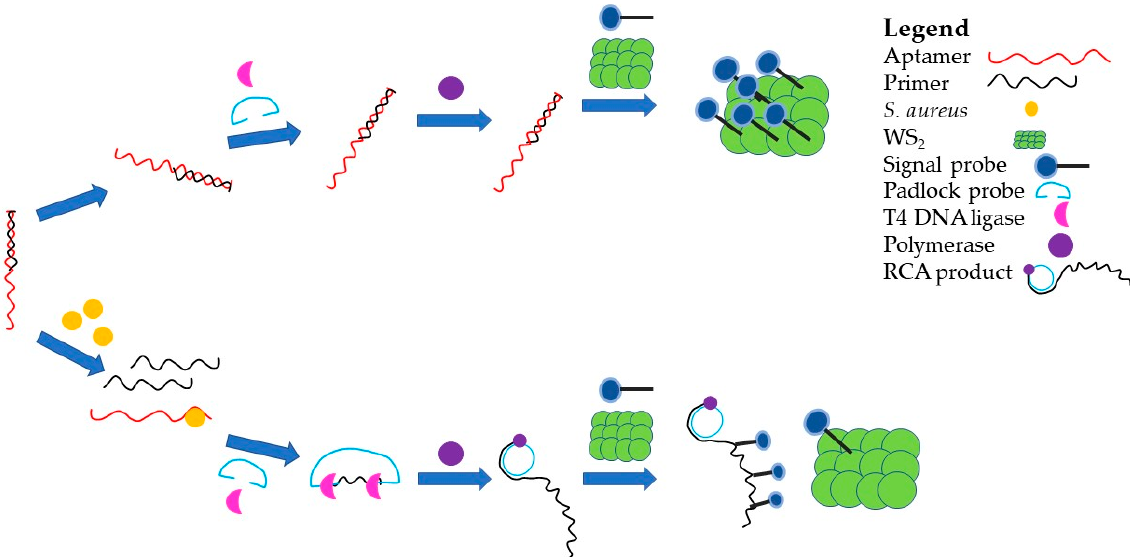
Figure 3. A schematic representation of an aptamer-based detection system developed by Hao et al. [67]. A representation of an aptamer-based detection system utilizing RCA, whereby an aptamer is bound to an RCA primer. When in the presence of S. aureus, the aptamer binds preferentially to the bacteria releasing the primer to begin RCA. The formation of the RCA product acts as a target for an added signal probe, creating a readable signal. In the absence of S. aureus , the primer is not released and the RCA product is not created, which leads to the signal from the probe being quenched by a WS 2 nanosheet [67].